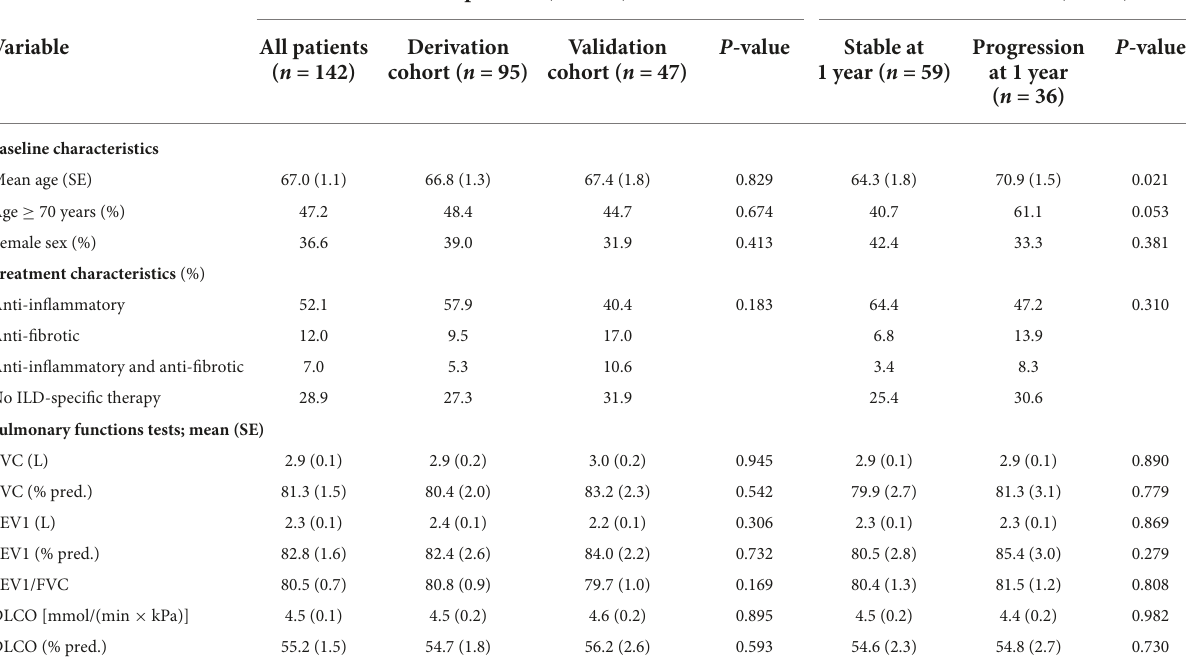
TABLE 1 Baseline patient, treatment, and pulmonary function test characteristics in all patients, the derivation, and the validation cohort as well as in the derivation cohort according to progression at 1 year. All patients ( n = 142)